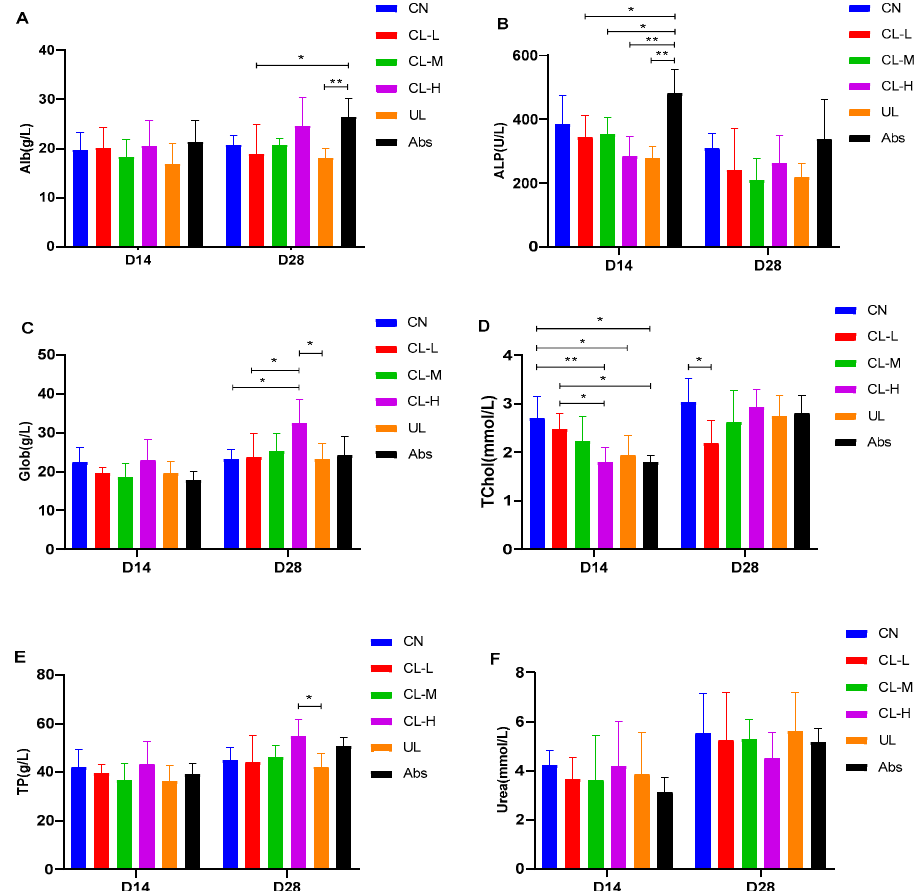
Figure 1. Effects of the CN, CL-L, CL-M, CL-H, UL, and Abs dietary interventions on the serum immunologic indexes of piglets. ( A – F ) Albumin (Alb), alkaline phosphatase (ALP), globulin (Glob), total cholesterol (TChol), total protein (TP), and urea levels and albumin–globulin ratio (A/G). The data are presented as the means ± SE ( n = 6). * indicates significant differences ( p < 0.05), ** represents very significant differences ( p < 0.01).